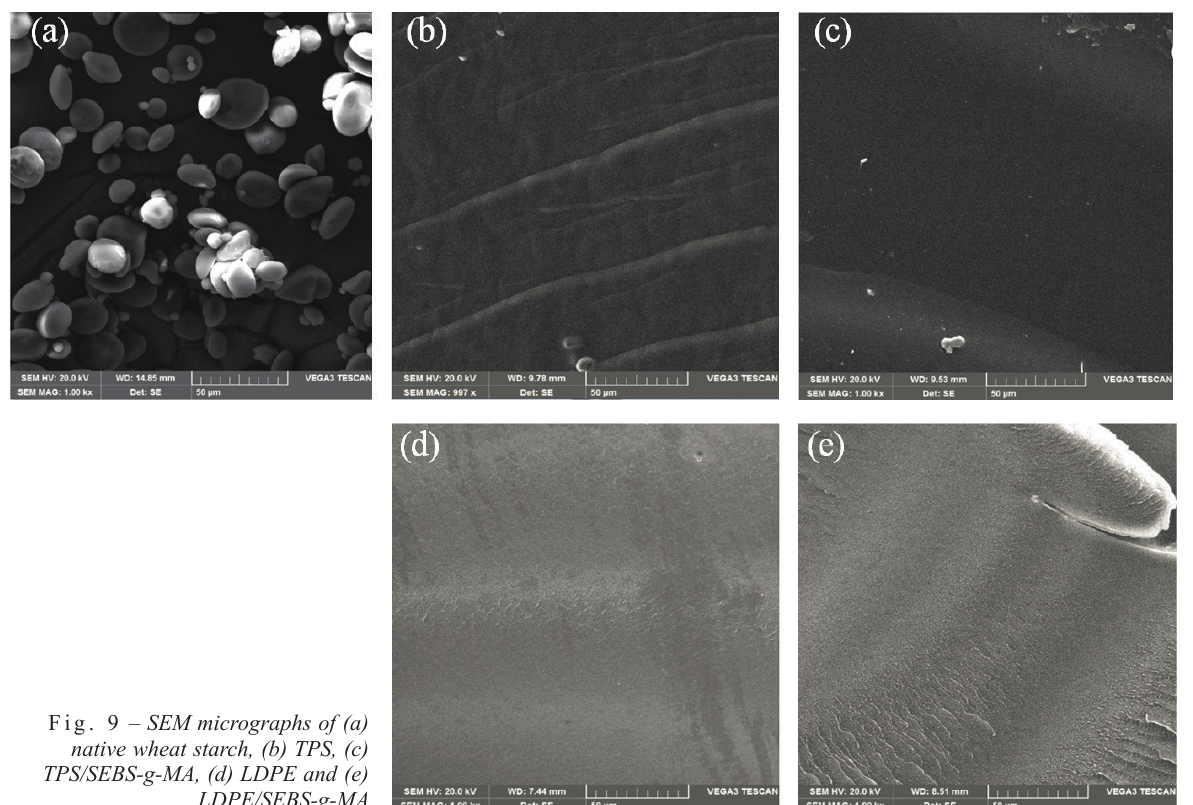
Fig. 9 – SEM micrographs of (a) native wheat starch, (b) TPS, (c) TPS/SEBS-g-MA, (d) LDPE and (e)